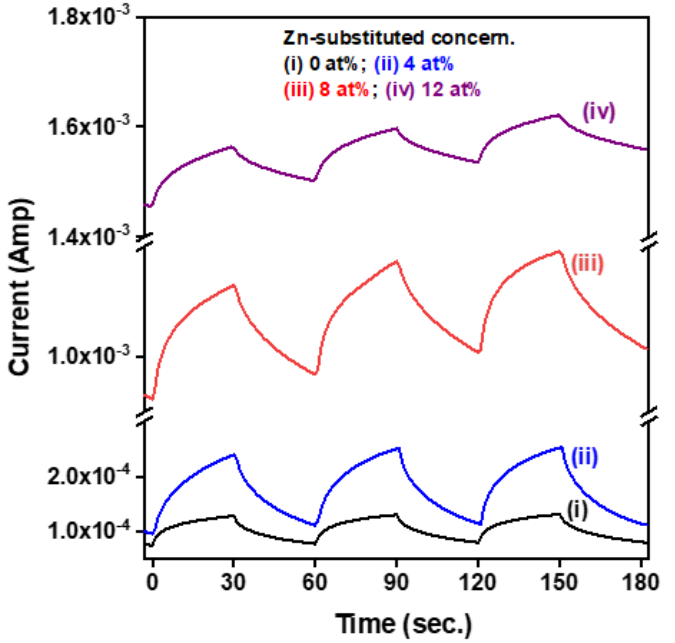
Figure 7. Time-resolved photoresponse characteristics of CuI-based MSM photodetectors under UVA light illumination and with an applied a bias voltage of 0.5 V. The interval time of periodically switching the UVA light on and off was 30 s. Table 2. Mathematical relation and calculated results of photodetection properties of pure CuI and Zn-substituted CuI MSM photodetectors.